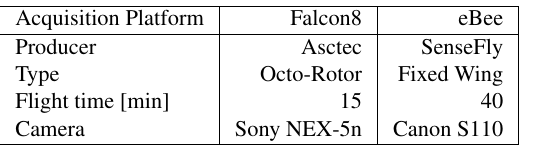
Table 1. Hardware details of the two UAVs used for data acquisition.